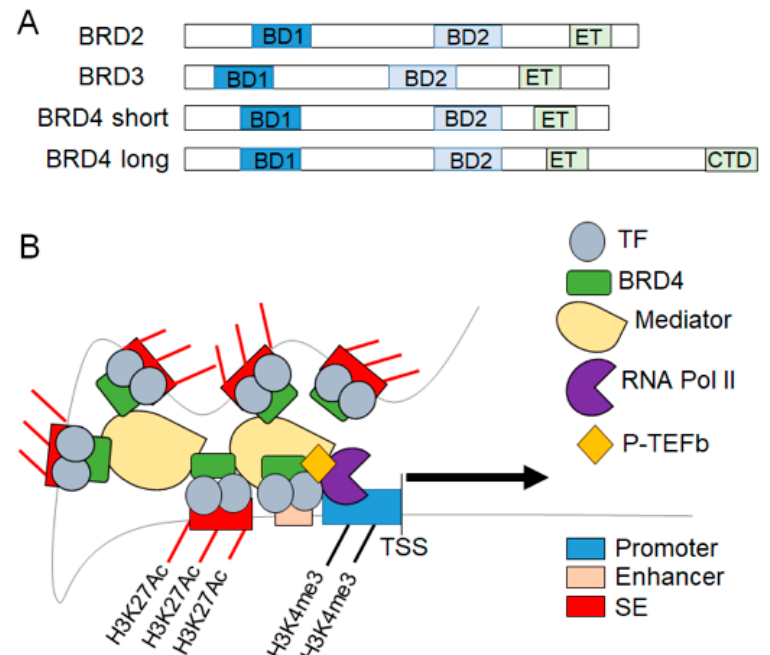
Figure 2. BET protein mediated transcription elongation. ( A ) The BET family of proteins contain two bromodomains (BD1, BD2). BRD4 is expressed as both a long and short isoform. BRD4 long contains a unique c ‐ terminal domain (CTD) that interacts with P ‐ TEFb, whereas BRD4 short lacks the CTD. ( B ) Schematic representation of the role of BRD4 in assembly of the transcriptional machinery involved in stress ‐ induced transcription elongation of target genes in the heart. TF, transcription factor; P ‐ TEFb, positive transcription elongation factor b; SE, superenhancer; TSS, transcription start site; red ‐ line, H3K27Ac marks on the SE.